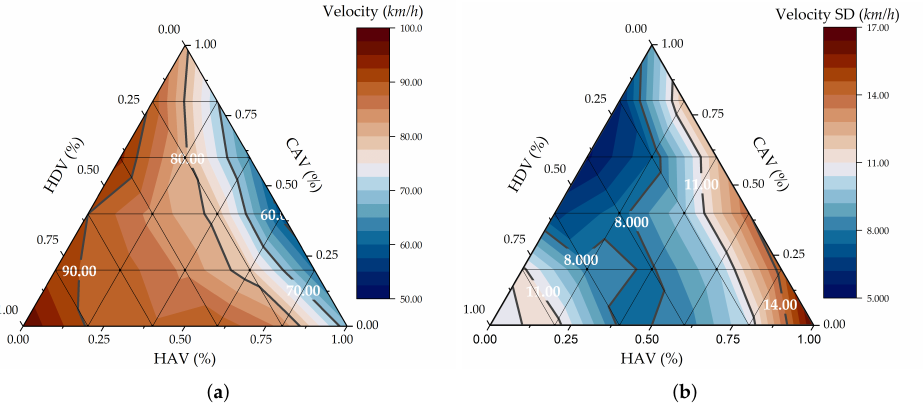
Figure 10. ( a ) Average speed over the network with mixed traffic; ( b ) Standard deviation of average speed over the network with mixed traffic.